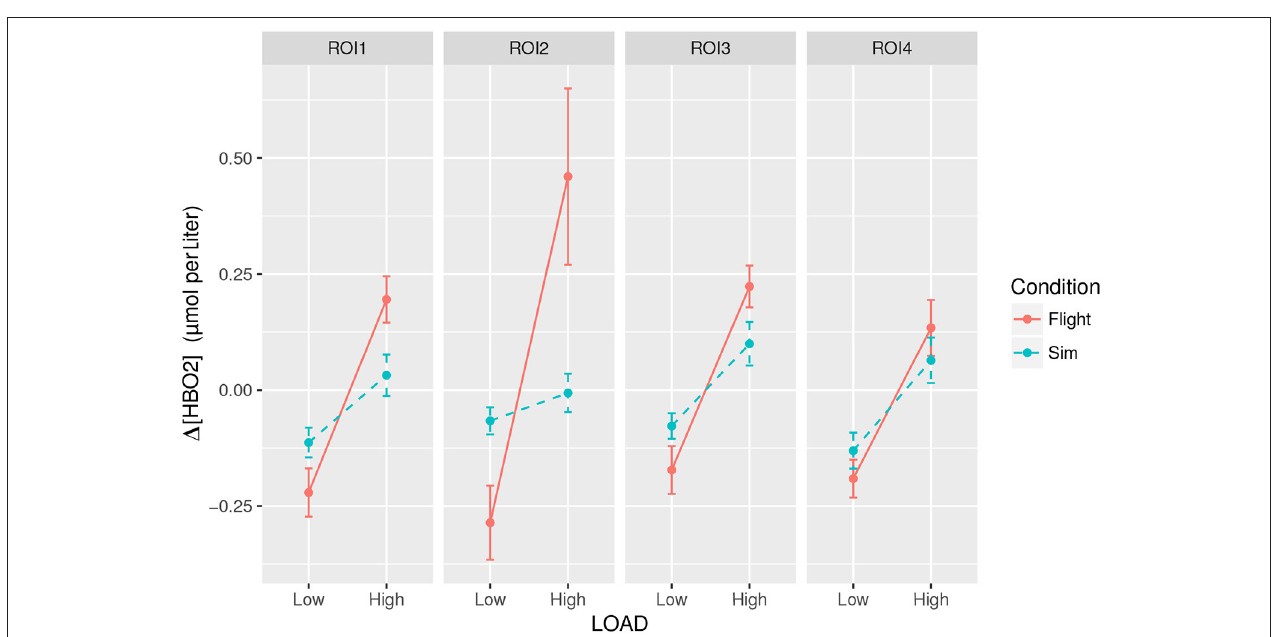
Frontiers in Human Neuroscience |